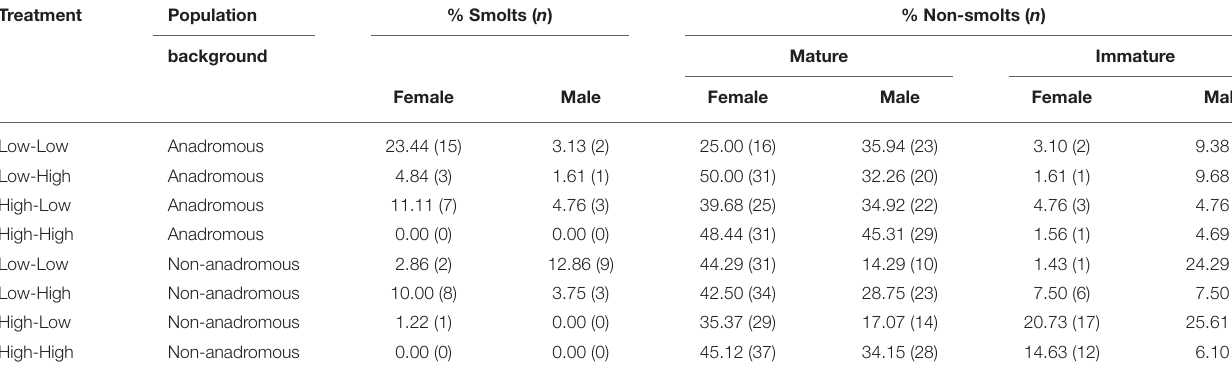
TABLE 1 | Percentage of brown trout ( n = 567, F1 offspring of wild trout from two population backgrounds) classed as smolts (i.e., migratory tactic) or non-smolts (mature or immature) after 2 years of experimental tank-rearing. Treatment